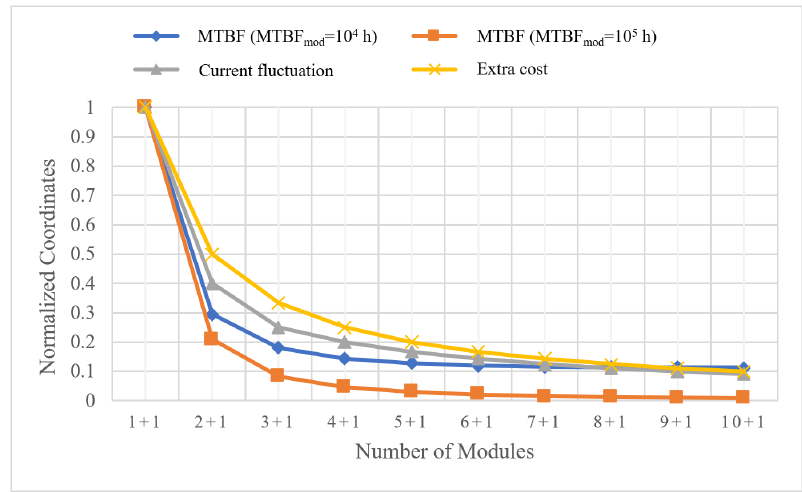
Figure 2. Trend curves of MTBF, current fluctuation, and extra cost with an increasing number of power modules.